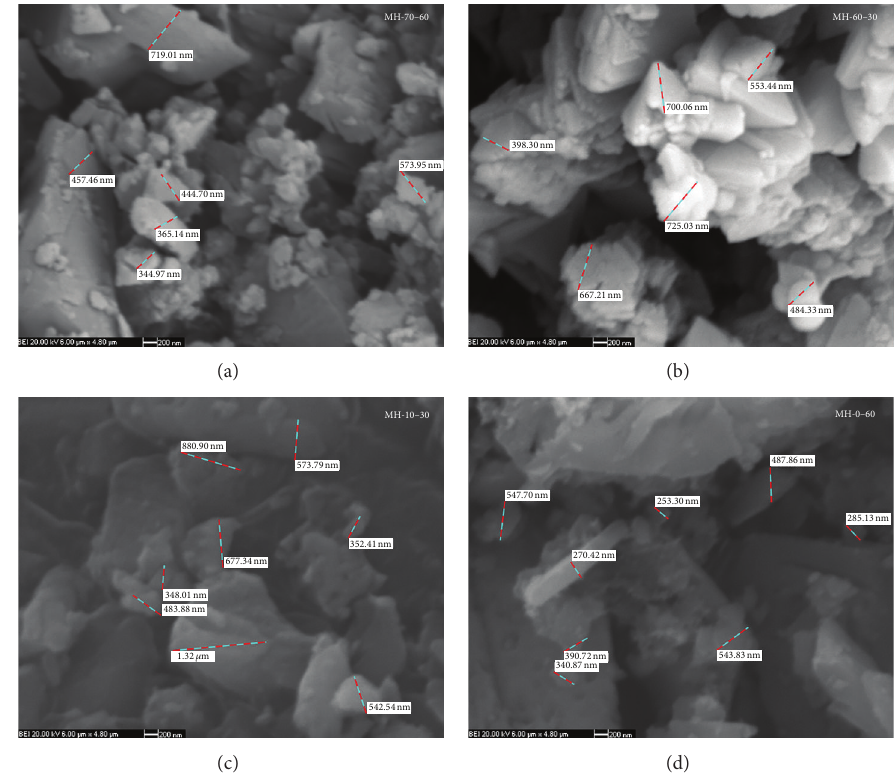
Figure 6: SEM surface morphologies of synthesized pure mcallisterite minerals at 20000x magnification.